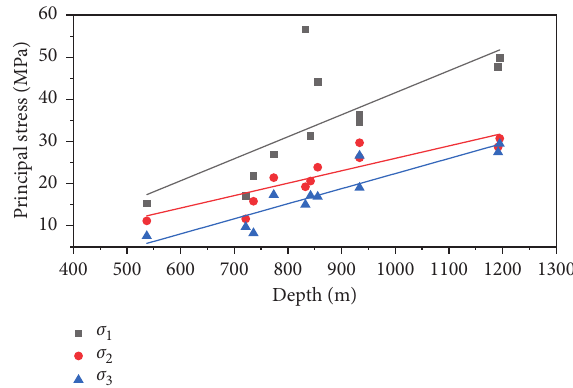
Figure 2: The variation of the principal stress with the